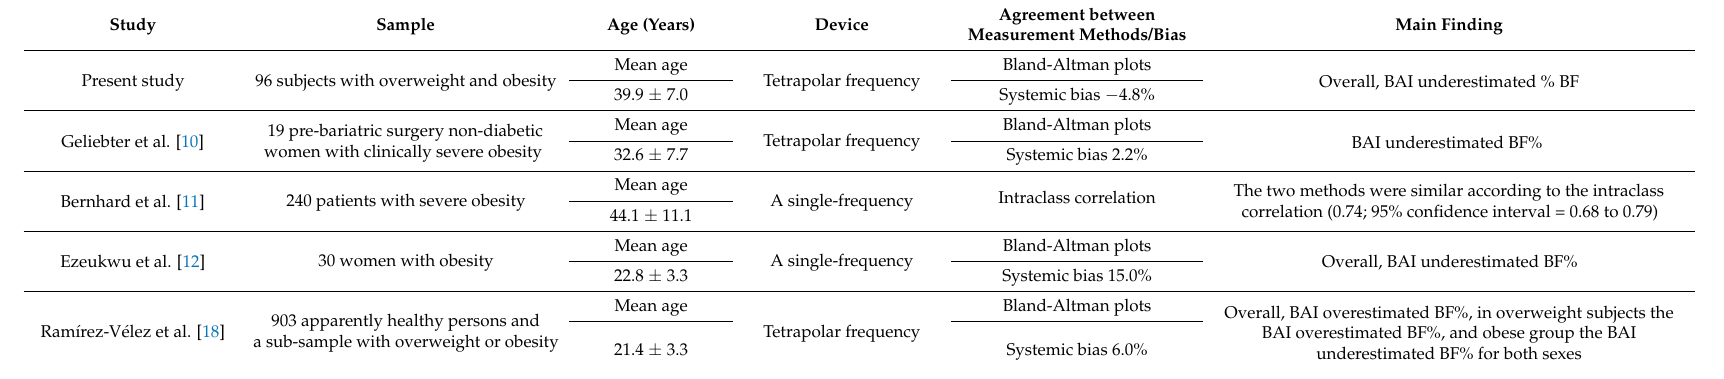
Table 4. Comparison of BF%-BAI parameters of the trials